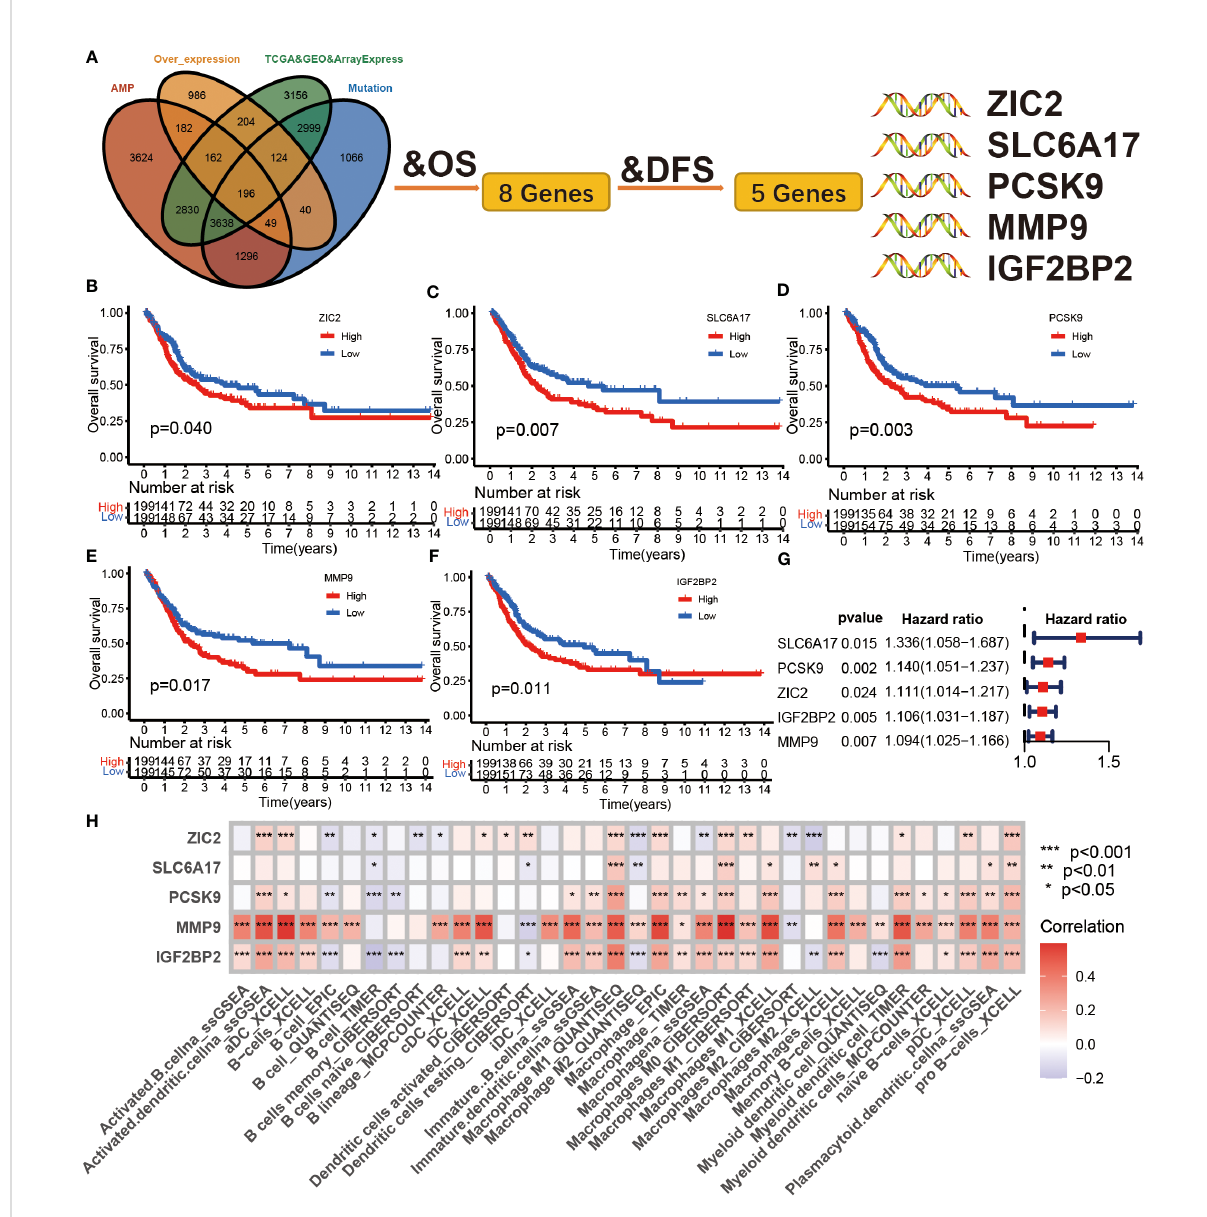
FIGURE 2 Identi fi cation of tumor antigens associated with clinical outcome in BLCA. (A) Tumor antigens signi fi cantly associated with OS and DFS from over expression, highly ampli fi ed, and mutated overlapping genes. (B-F) Kaplan-Meier survival curve analysis for ZIC2 (B) , SLC6A17 (C) , PCSK9 (D) , mmp9 (E) , and IGF2BP2 (F) genes in the TCGA BLCA cohort. The log-rank test was used to determine the statistical signi fi cance of the differences, and P< 0.05 was considered signi fi cant. (G) The univariable COX analysis of fi ve potential tumor antigens in TCGA BLCA cohort. (H) The correlation between APCs and fi ve tumor antigens in the Meta